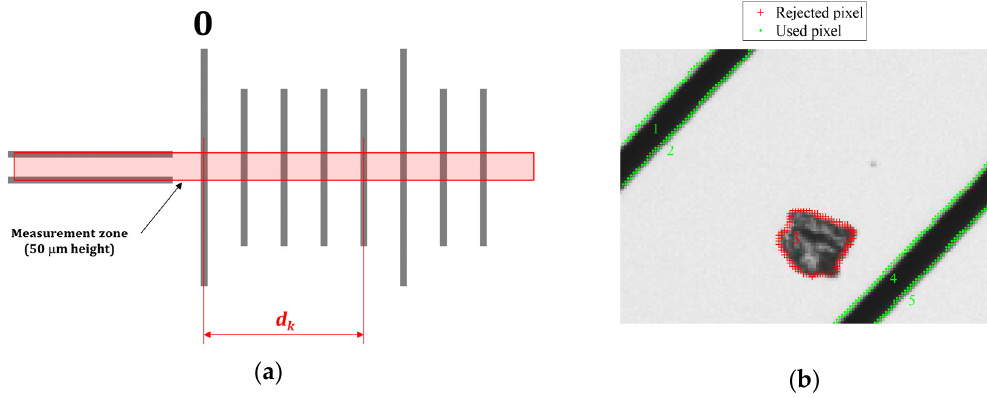
Figure 2. ( a ) Glass line scale. ( b ) Edges detected by processing the image of the line scale. Table 2. Calibration data of the glass line scale. Table 2. Calibration data of the glass line